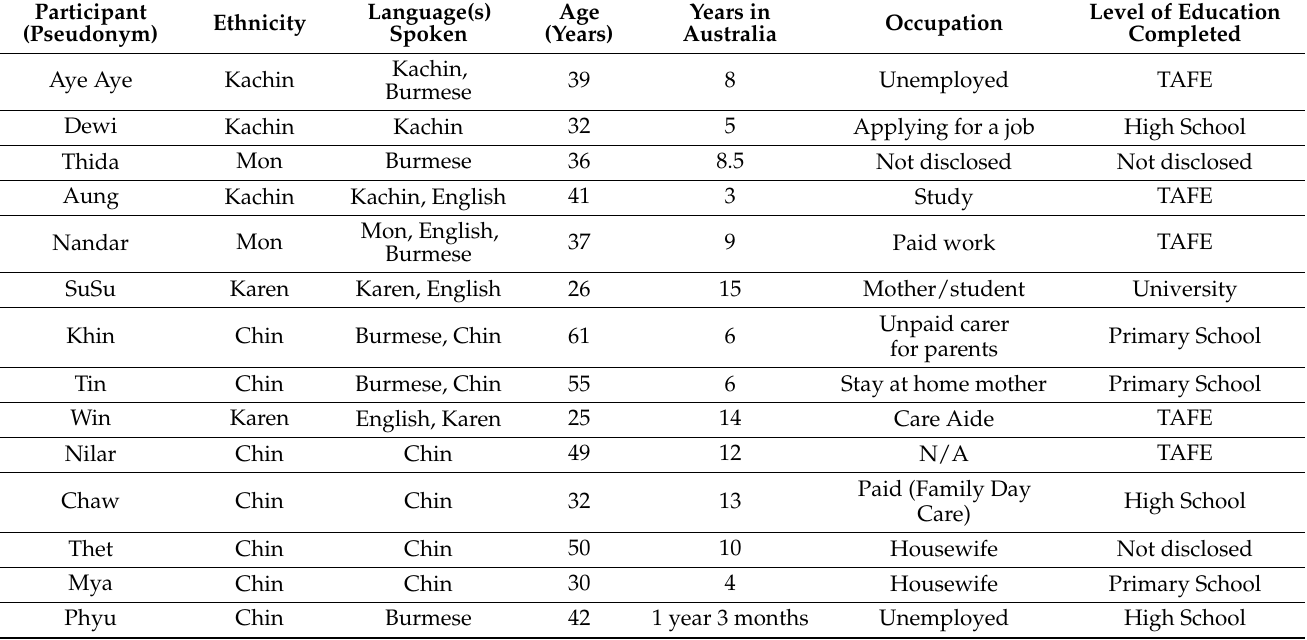
Table 1. Participant